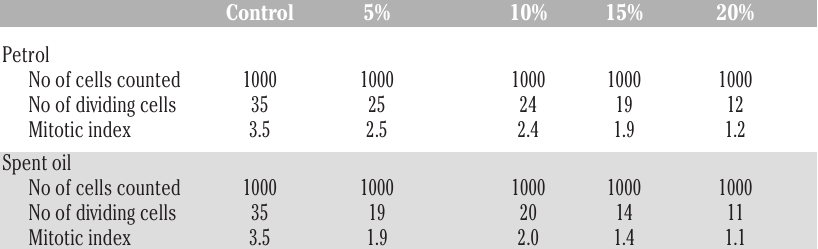
Table 5. Effect of petroleum products on the mitotic indices of Guinea